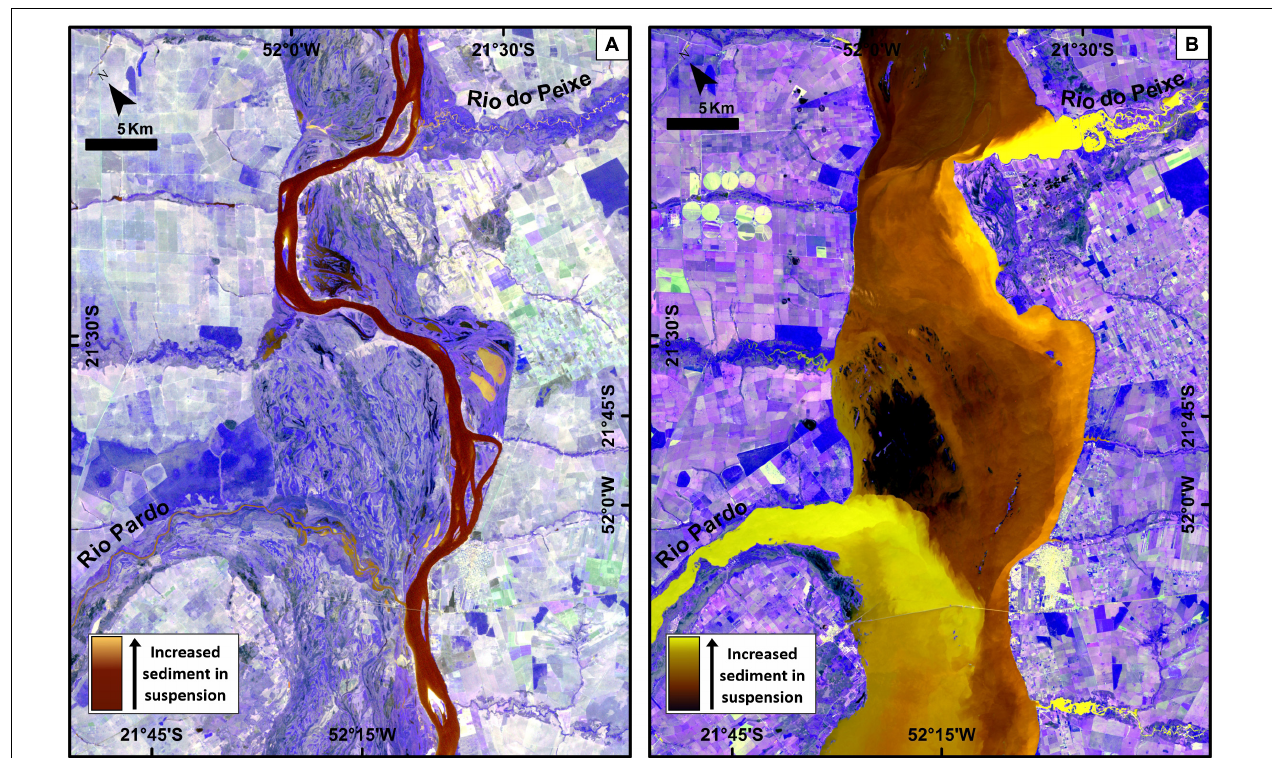
FIGURE 9 | The influence of tributaries in the morphology of the Paraná River. (A) Landsat – 5 image, composition 2R3G4B (August 15, 1985 – before the dam); (B) Landsat – 8 image, composition 3R4G5B (September 21, 2016). The contrast between beige/light yellow which represent the sediments in suspension delivered by the tributaries, and the brown tones that indicate diminished or absent suspended sediments in the Paraná